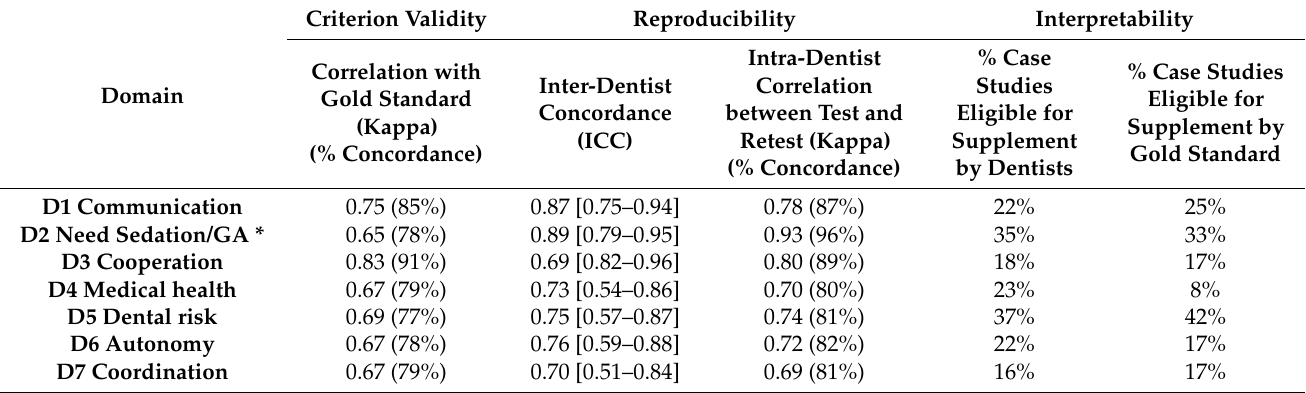
Table 5. Summary of the test–retest